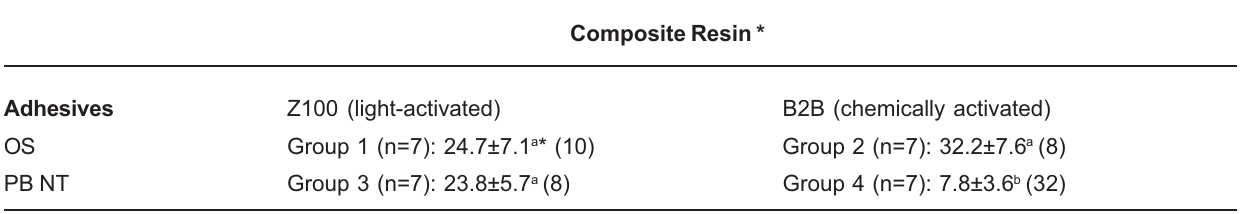
*Different superscript letters indicate statistically significant difference